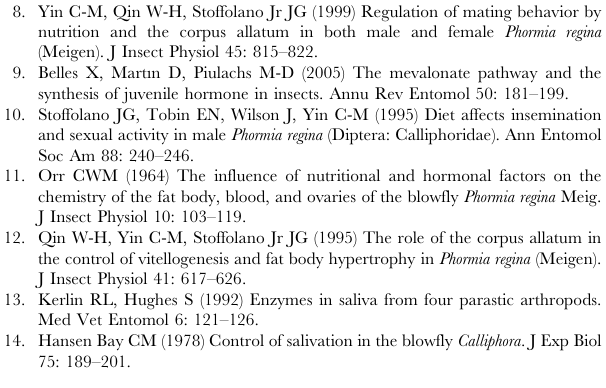
Figure S1 Mass-finger printing of recombinant Preg- OBP56a. A, Mass-fingerprinting of recombinant PregOBP56a. Molecular weight and corresponding positions were represented. Peaks with asterisks were [M + Na] + ions. B, Tryptic fragments of PregOBP56a. Identified fragments were represented in bold letters. (PPT) Figure S2 MALDI TOF mass spectrometry of recombi- nant PregOBP56a.